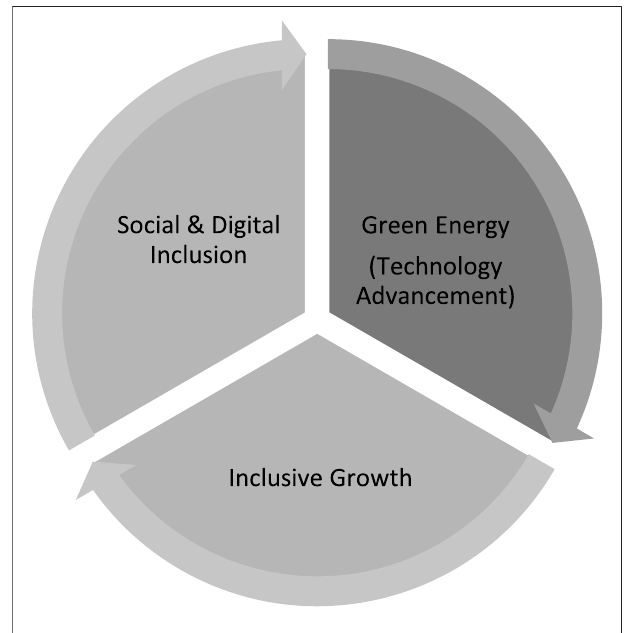
FIGURE 1 | Radial diagram of key